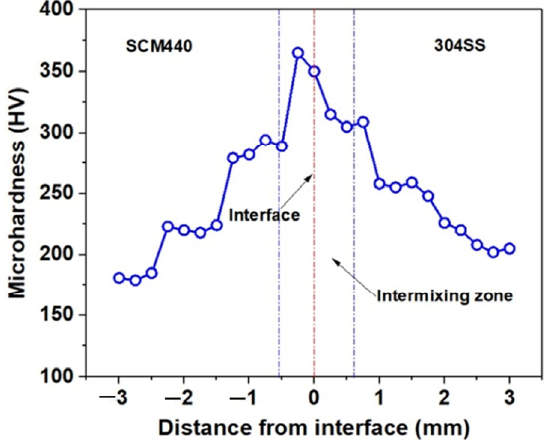
Figure 11. Microhardness of the dissimilar friction welded joints.